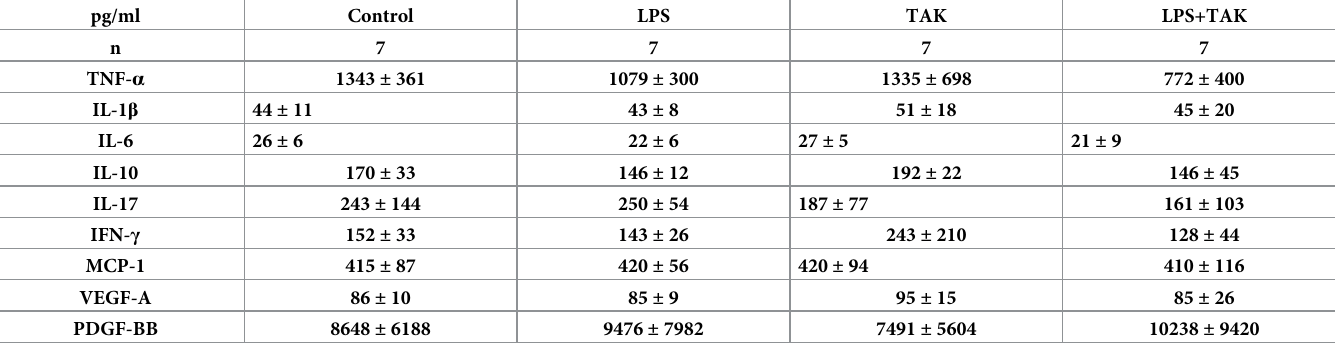
Table 1. Serum levels of pro-inflammatory cytokines, PDGF-BB and VEGF.